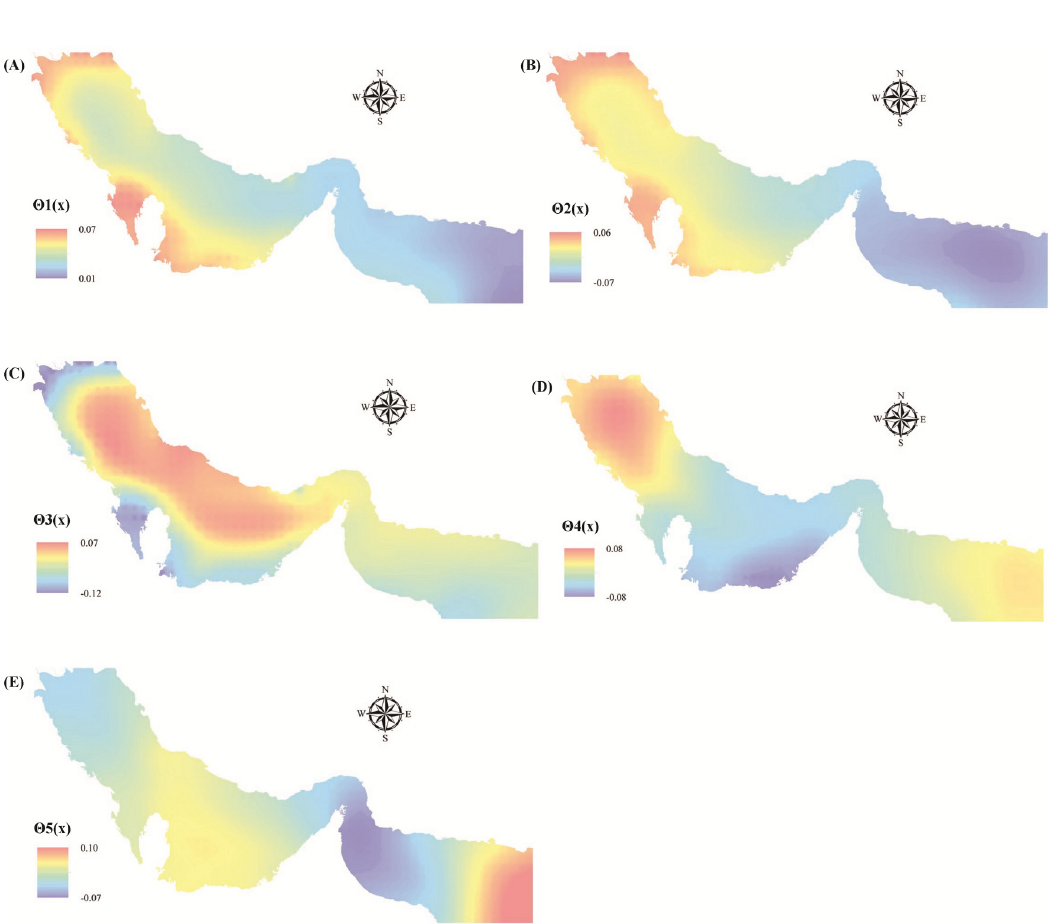
Fig 6. Pattern of space-dependent terms for ( A ) the first mode Θ 1 ( x ), ( B ) the second mode Θ 2 ( x ), ( C ) the third mode Θ 3 ( x ), ( D ) the fourth mode Θ 4 ( x ), and ( E ) the fifth mode Θ 5 ( x ).